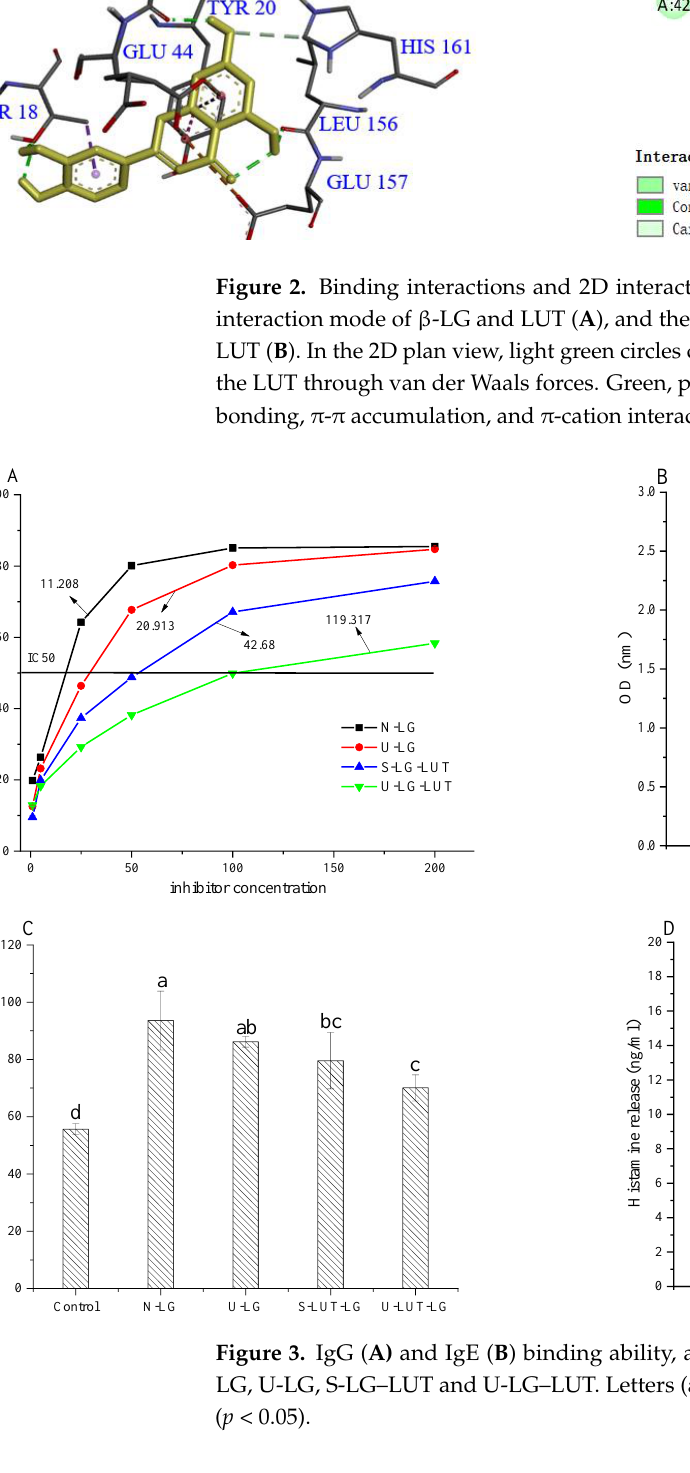
Figure 2. Binding interactions and 2D interaction diagrams of LUT binding with β -LG. The 3D interaction mode of β -LG and LUT( A ), and the 2D plan view of the interaction between β -LG and LUT( B ). In the 2D plan view, light green circles correspond to amino acid residues that interact with the LUT through van der Waals forces. Green, purple, and orange dashed lines represent hydrogen bonding, π - π accumulation, and π -cation interactions, respectively.